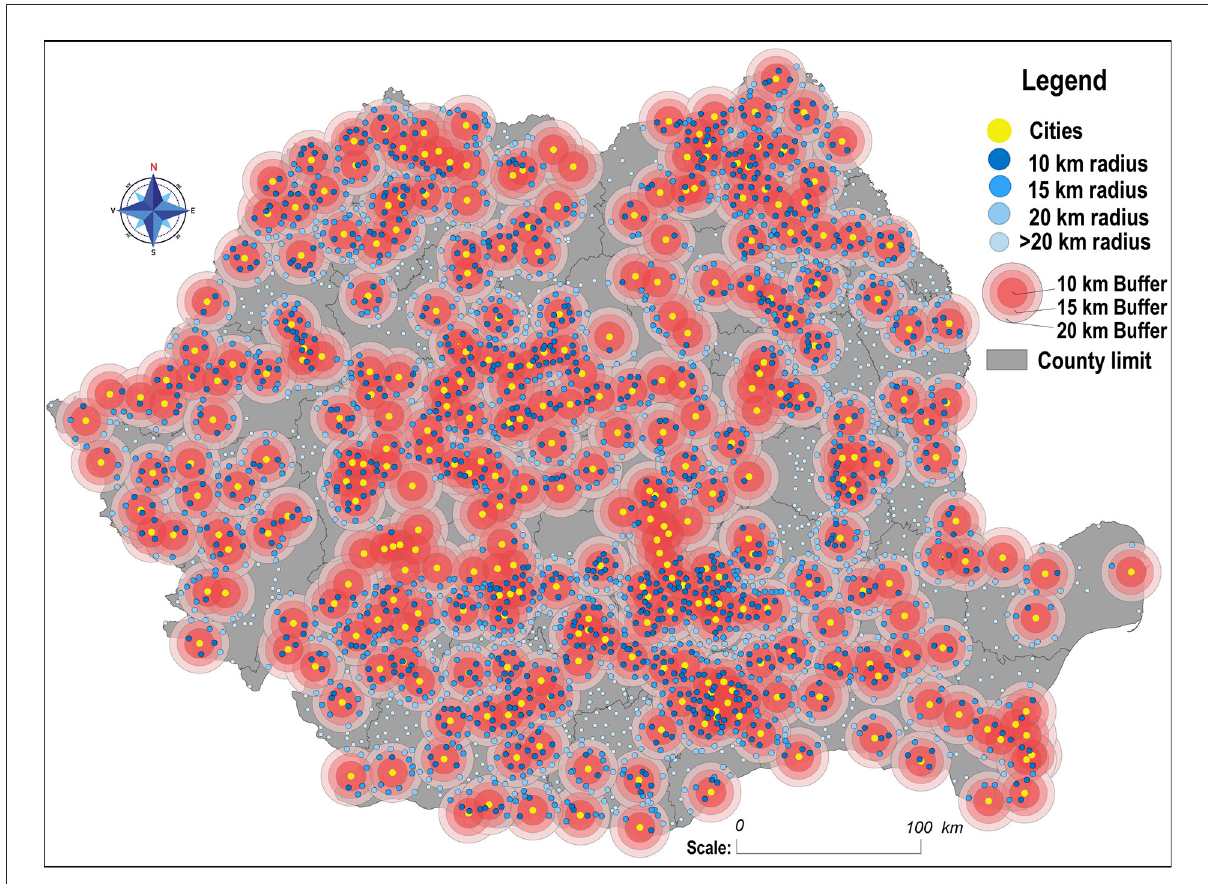
FIGURE3 Classification of communes according to proximity to the nearest urban